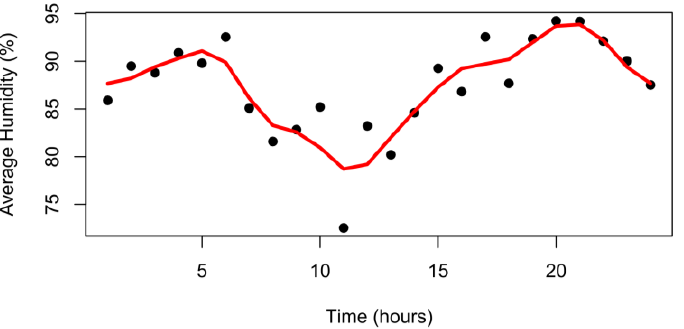
Figure 5. Smoothed curve (using a Fourier basis fit) of the daily average humidity corresponding to 1 January 2014.